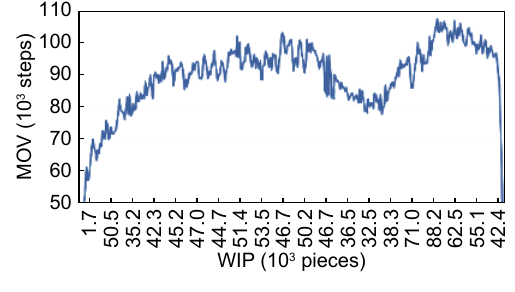
Fig. 4 Trend line of MOV and WIP.